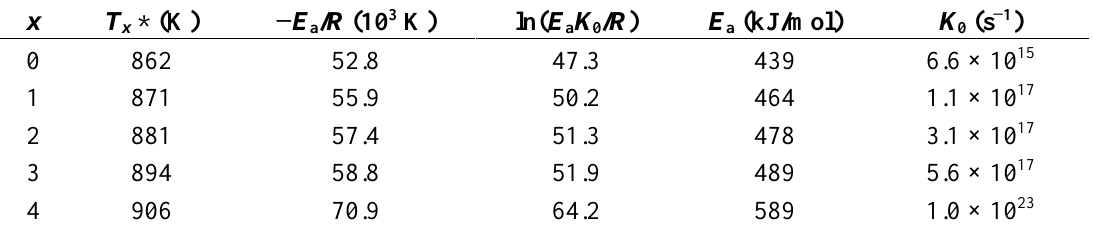
* Measured at a heating rate of 0.667 K/s.